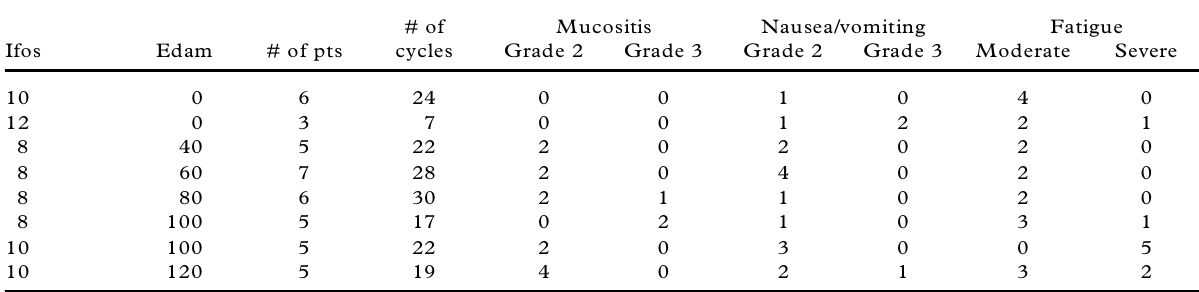
Table 5. Number of patients with selected non-hematologic toxicities for all cycles of ifosfamide + G-CSF +/± edatrexate